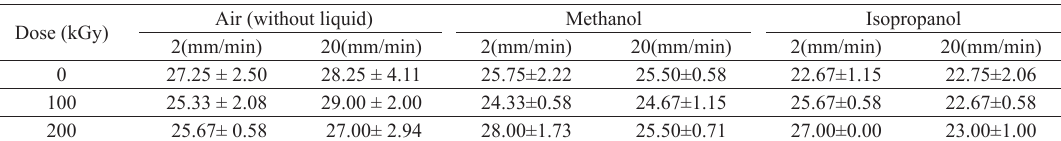
Table 1. Tensile stress at break (MPa) of PC under air, methanol and isopropanol as function of absorbed dose, with crosshead speeds at 2 and 20 mm/min. Dose (kGy)